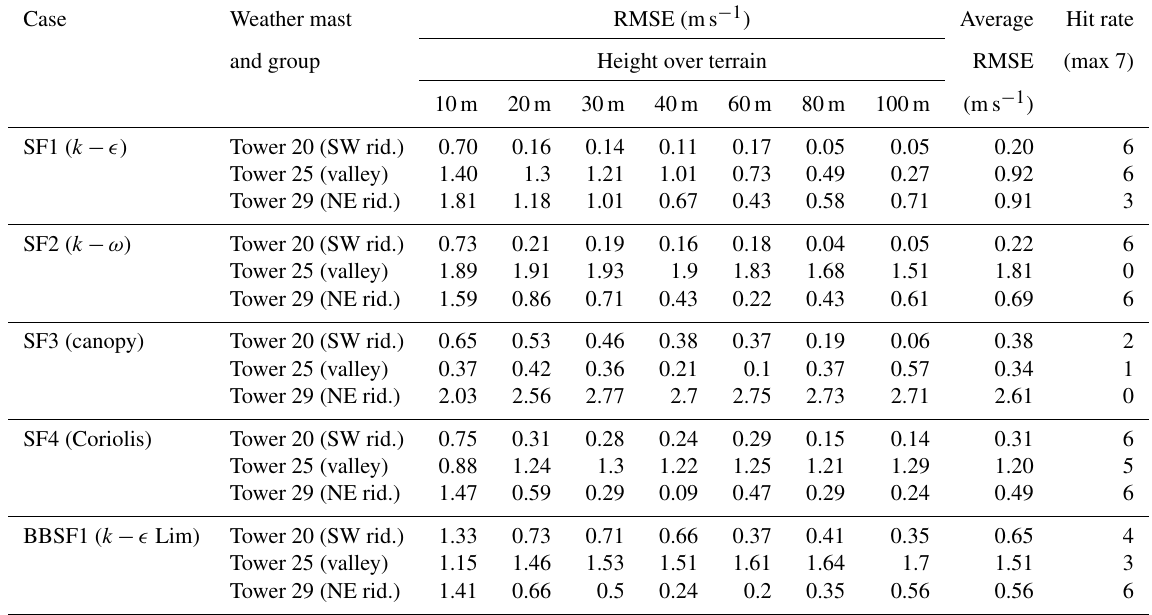
Table 4. RMSE for wind speed predictions on the main towers of interest.